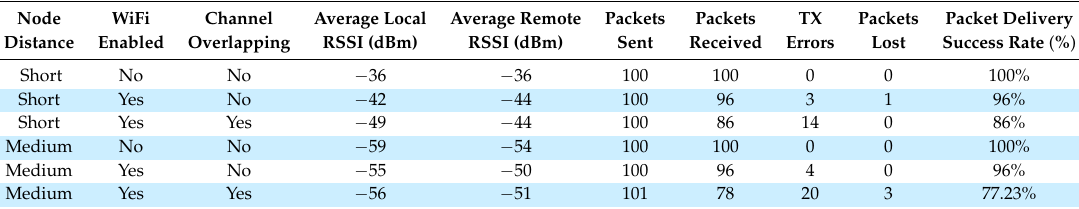
Table 9. ZigBee success delivery rate in the presence of WiFi